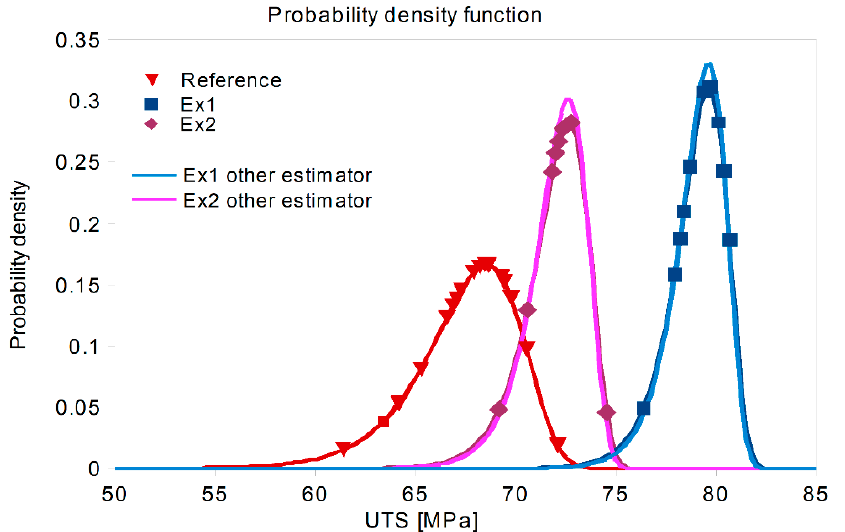
Figure 7. The probability density function (Weibull curve) of the reference data versus the results of both ultrasound treatments based on UTS measurements. The data points are overlayed on the calculated distribution indicated in Figure 6. Two lines labelled as “other estimator” show the other possible distributions, calculated with another estimator, as will be discussed further (method 3 in Table 4).